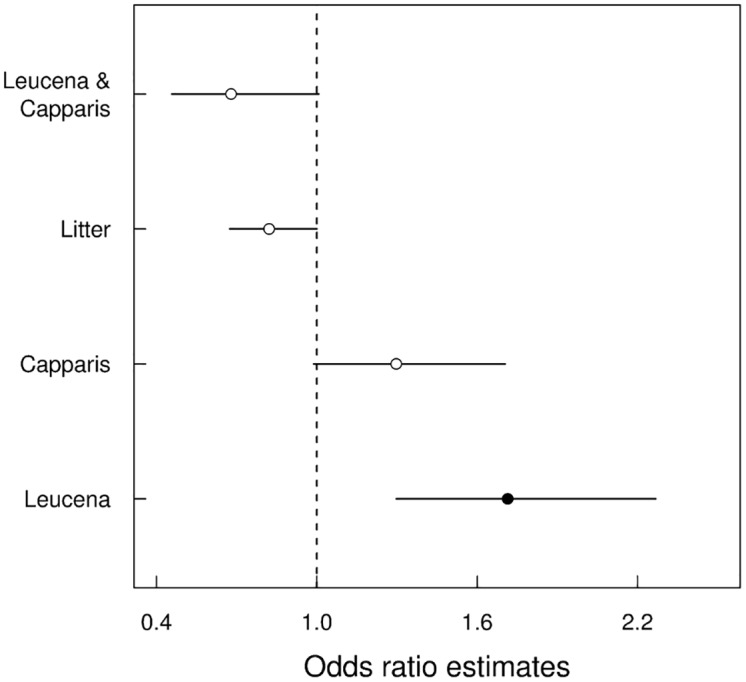
Odds ratios of model 5 (lowest AIC—Table 1), describing the germination of the native species Erythrina velutina in a field experiment.Circles show the odds ratios for each treatment, with the 95% confidence limit (CL) represented by the horizontal lines. Odds ratios that include a ratio of 1 within the 95% CL are indicated with empty circles.